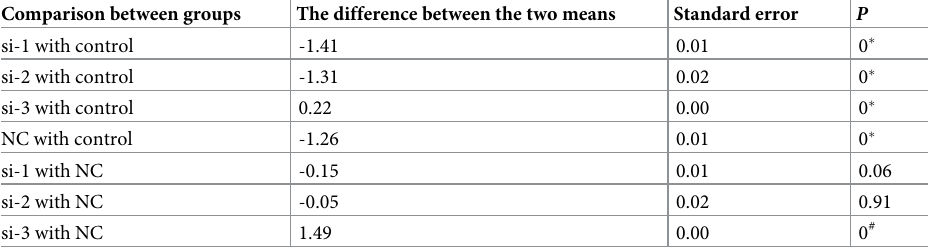
Table 5. Western blot detection of the relative expression level of GSDMB protein in each group of cells. Comparison between